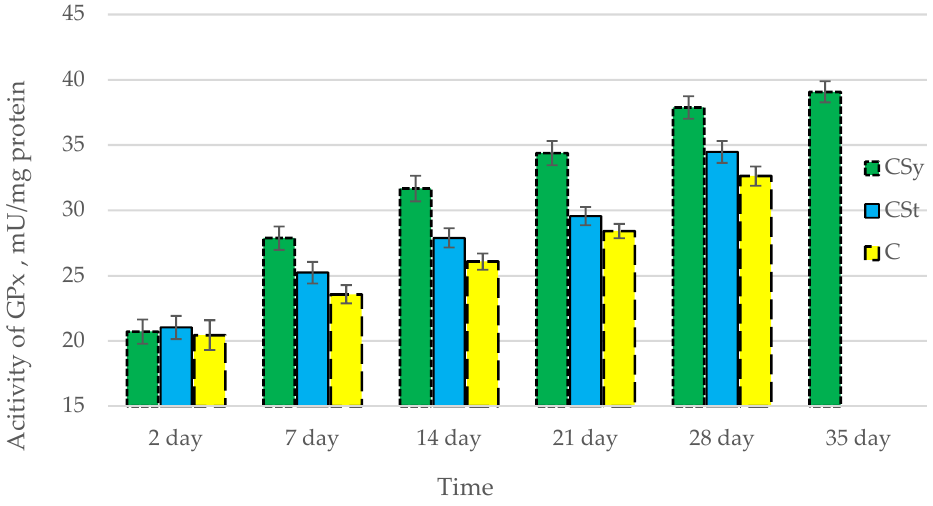
Figure 4. Activities of Glutathione Peroxidase (GPx) in the 2-, 7-, 14-, 21-, 28-, 35-day-old honey bees’ hemolymph after two methods of supplementation with hemp extract: C—control (pure sugar syrup), Csy—hemp extract in syrup, Cst—hemp extract on strips. (Two-Way ANOVA: supplementation method: F (2,146) = 145,31, p = 0.0000; days of supplementation: F (4,138) = 1093,6, p = 0.0000; supplementation method × days of supplementation F (8,138) = 22,266, p = 0.0000.